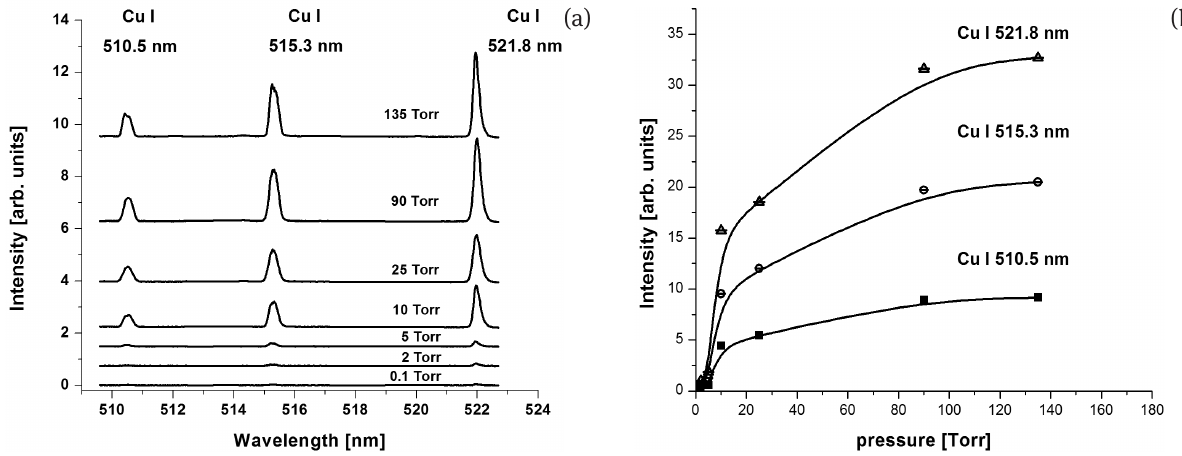
Figure 3: Intensity of copper analytical spectral lines (Cu I 510.5 nm, Cu I 515.3 nm and Cu I 521.8 nm) from laser-induced plasma as a function of ambient gas